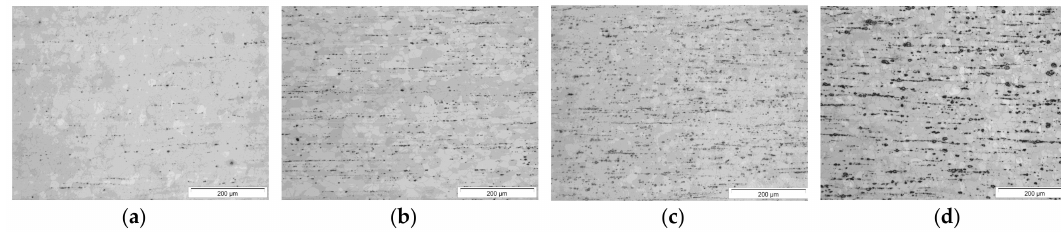
Figure 1. Microstructure of extruded alloys: ( a ) Mg10Gd; ( b ) Mg10Gd1Nd; ( c ) Mg10Gd1La; and ( d ) Mg10Gd1Nd1La.